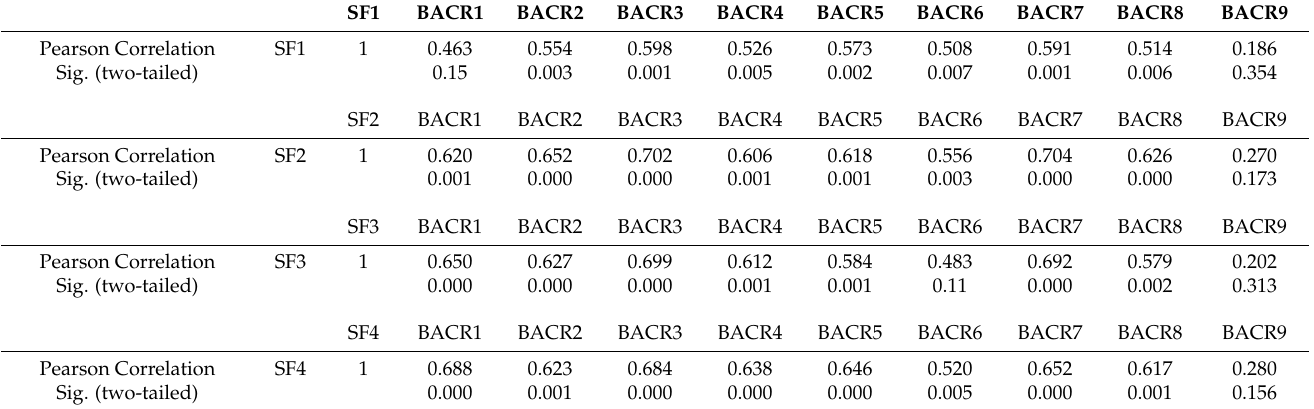
Table 4. Correlation analysis between NCC and resilient buildings and